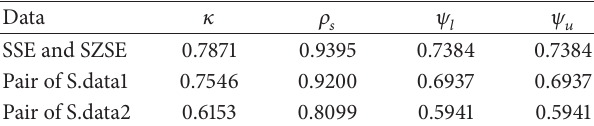
Table 1: Measures for concordance and tail dependence of returns. Data